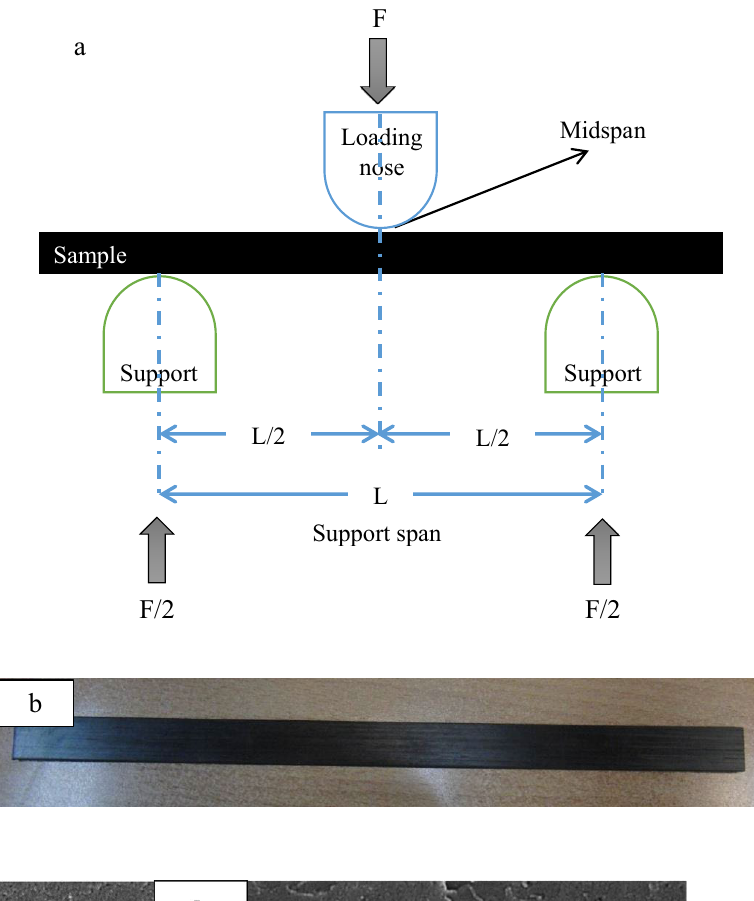
Fig. 4 ( a ) Schematic of the three-point bending test and ( b ) test sample